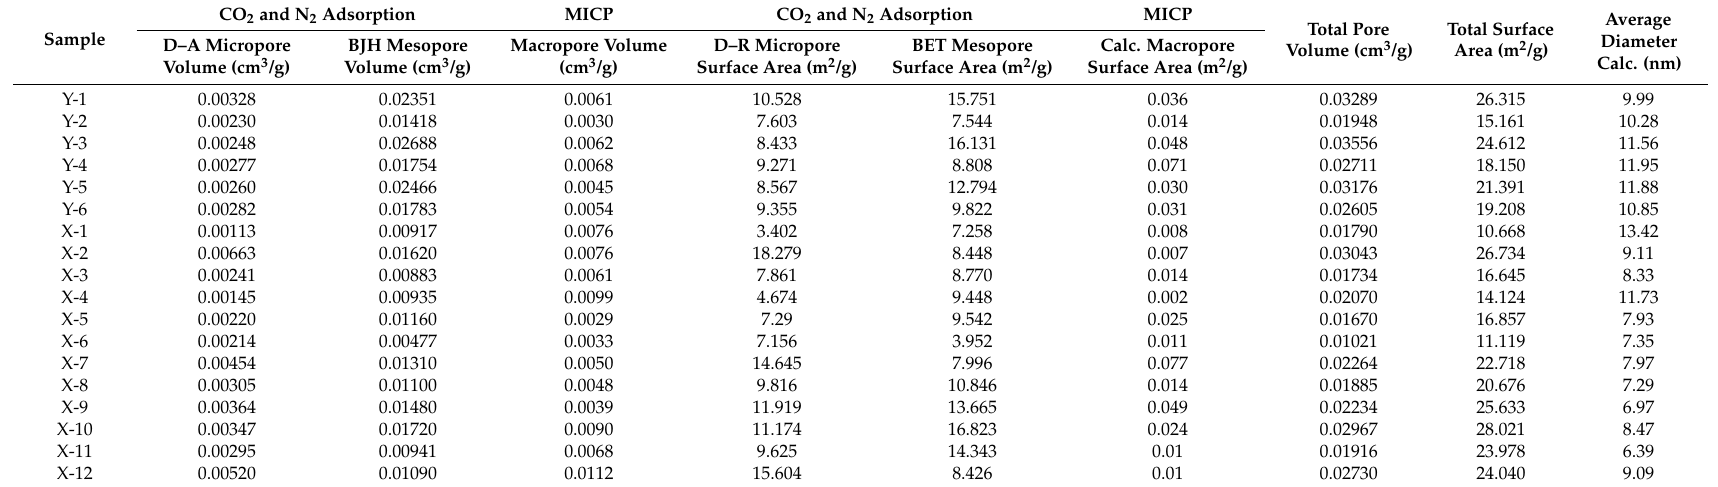
Table 6. Micropore, mesopore, and macropore structure parameters of transitional Longtan Shale samples from YV-1 and XD-1 determined by gas adsorption and MICP